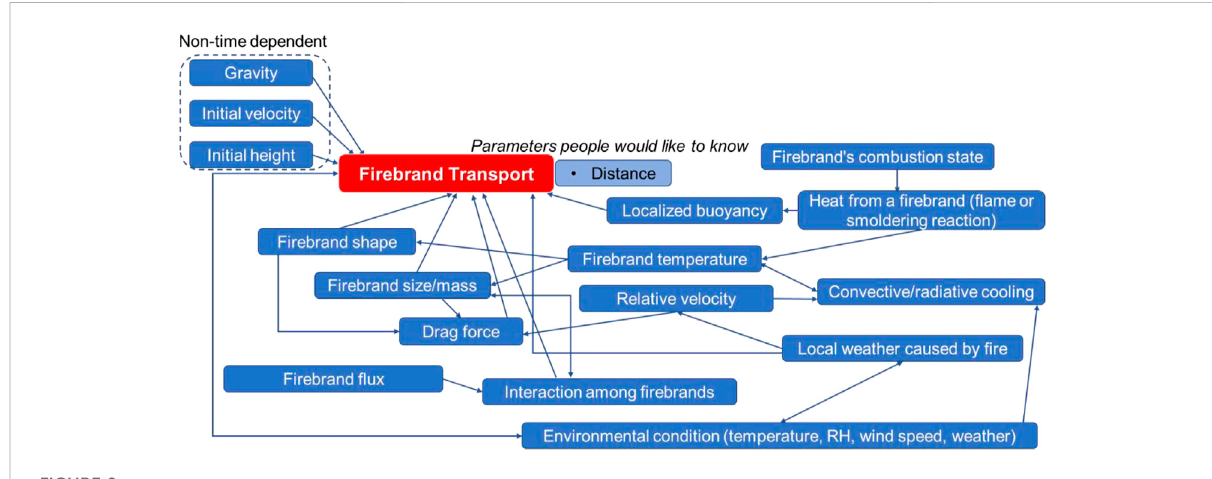
FIGURE 9 A listing of important factors that in fl uence fi rebrand transport